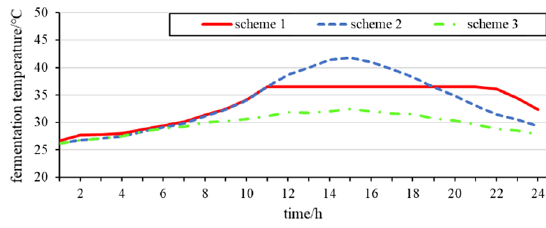
Fig. 16 Biogas fermentation temperature in